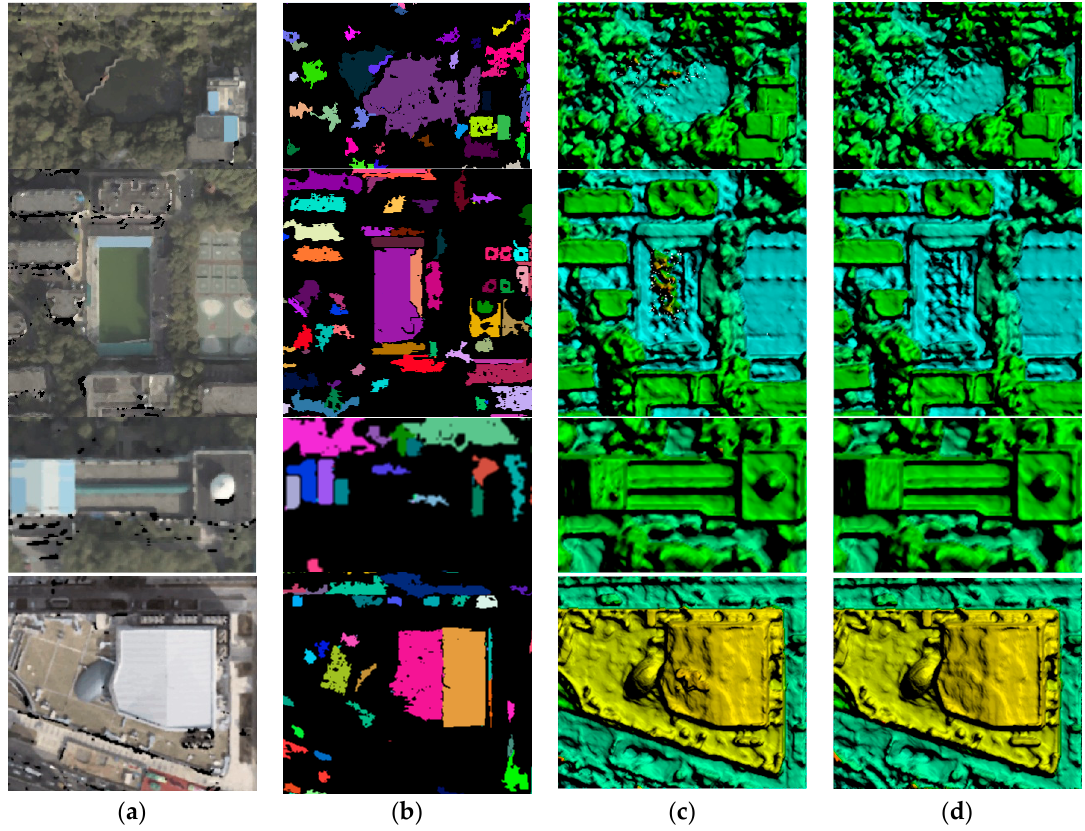
Figure 13. Results at weak texture regions: ( a ) true-orthophotos; ( b ) segmentation flag maps; ( c ) DSM generated without true-orthophoto guidance; and ( d ) DSM generated with true-orthophoto guidance.